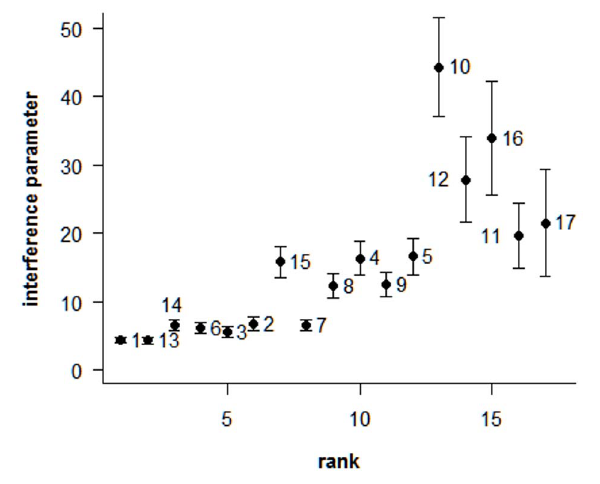
Figure S1 Distribution of MLH1 foci for all autosomes from the LW 1.0 and Meish. For each autosome, the x-axis indicates the position of the signals on the SC, from the q (left) arm to the p (right) arm. This axis is divided into a number of intervals proportional to the length of the SC. The Y-axis indicates the number of MLH1 foci in each interval. The vertical line in bold represents the centromere and the dotted line the average number of MLH1 signals per SC. For each autosome, the columns (from lighter to darker blue) indicate bivalent with 1, 2, 3 or 4 MLH1 foci.